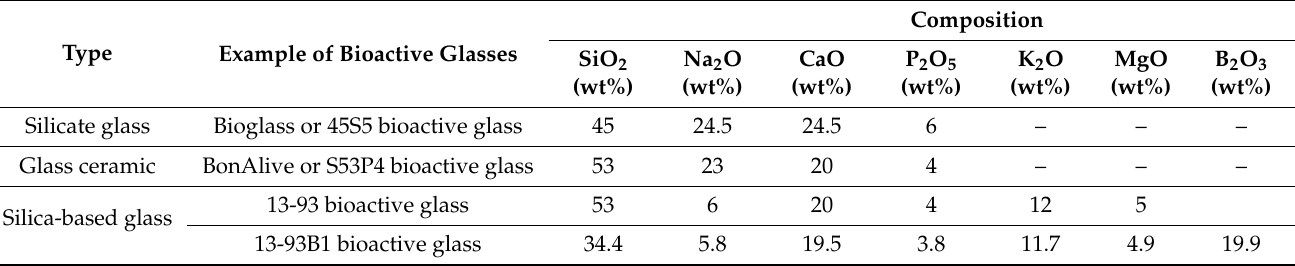
Table 1. Composition of different types of silica-based bioactive glasses [17,19–21].